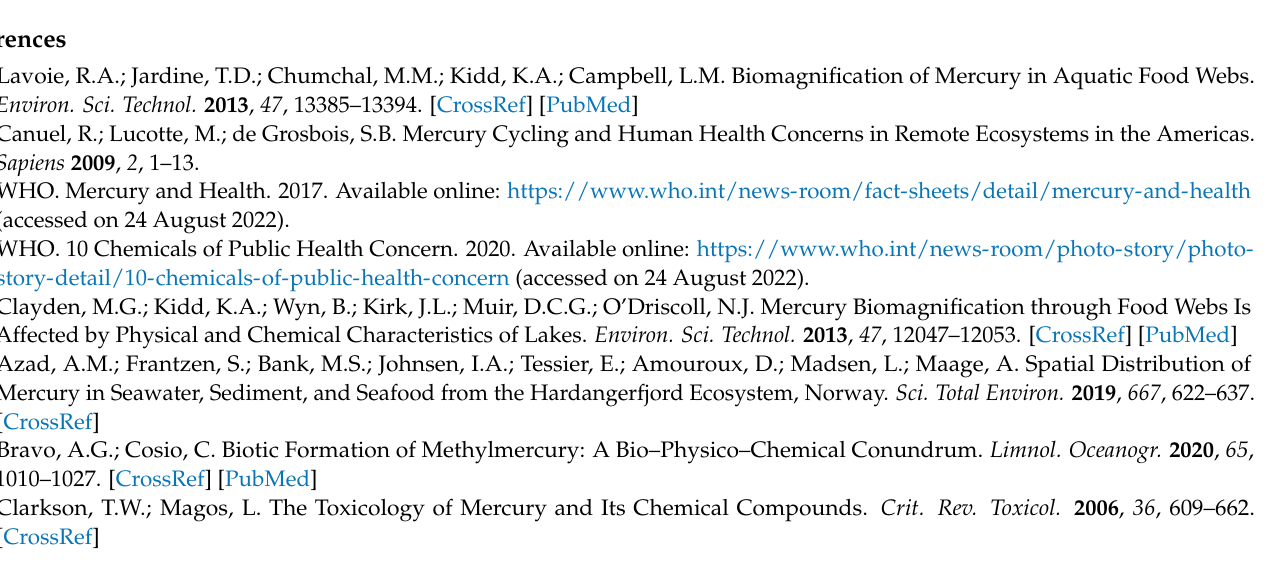
depth; Figure S3: Bar plot of relative abundance of phylum by the level of disturbance; Figure S4: Unconstrained correlations between environmental variables and classes of bacteria and archaea; Figure S5: A one-way ANOVA test on high and low concentration of mercury effect on Alpha diver- sity; Figure S6: A one-way ANOVA test on high and low concentration of methylmercury effect on Alpha diversity; Figure S7: Spearman correlation heatmap between environmental variables and Alpha diversity metrics; Figure S8: Abundance heatmap of the top 50 most abundant taxa, separated by the level of MeHg; Figure S9: Abundance heatmap of the top 50 most abundant taxa, separated by the level of disturbance; Figure S10: Differential abundance testing using DESeq2; Figure S11: Differential abundance testing using DESeq2; Figure S12: A one-way ANOVA test on seasonal effect on Alpha diversity; Table S1: Topographical characteristics of sub-catchments of watercourses corresponding to each sampling site; Table S2: Top 10 t indicator value for each level of disturbance; Table S3: Top 10 indicator species with highest indicator value for high and low concentration of methylmercury; Table S4: Top 10 indicator species with highest indicator value for high and low concentration of mercury; Table S5: Summary of indicator species affiliation to